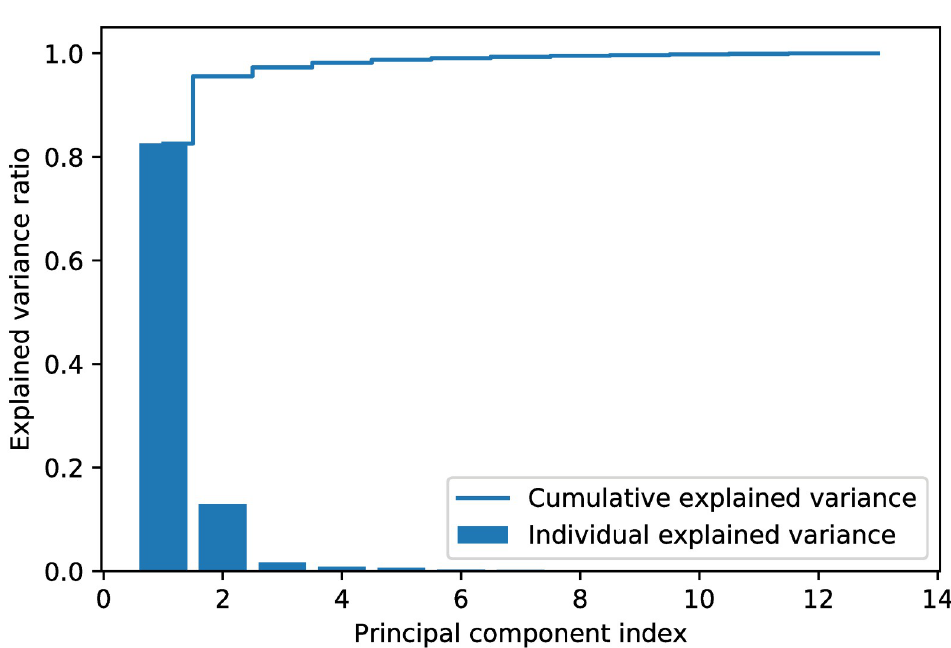
Fig 9. Explained variance ratio for the StatLib dataset.